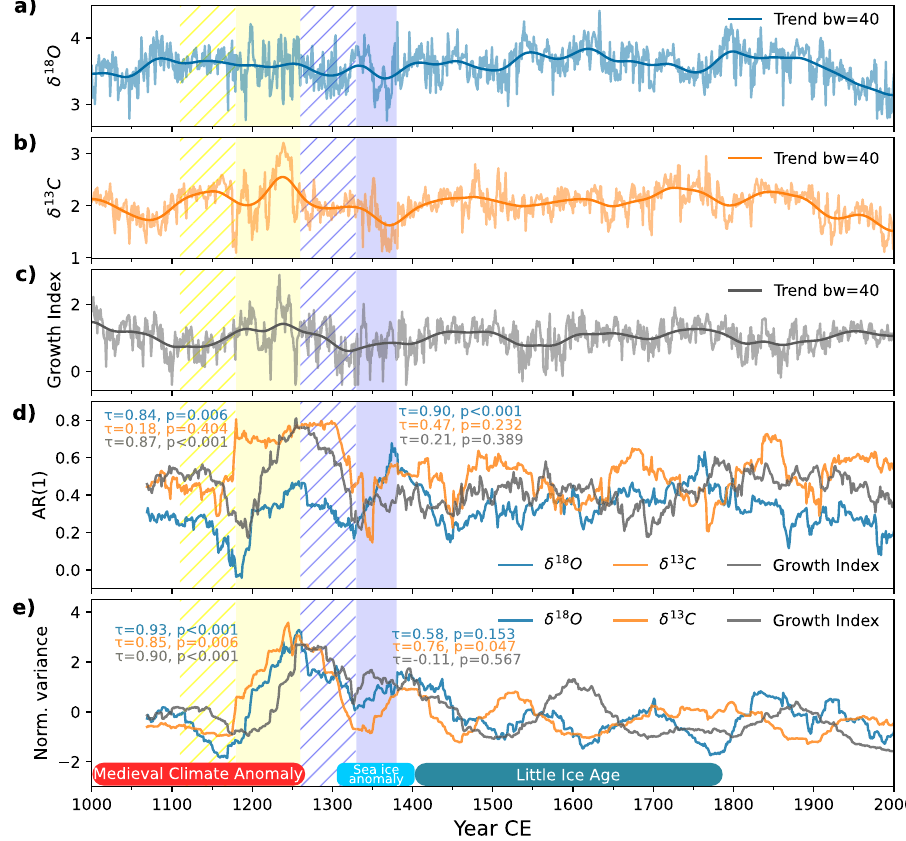
Fig. 2 | Resilience changes measured along the bivalve shell-derived records. a – c Annualvaluesforthe a δ 18 O 24 , b δ 13 C 25 ,and c GrowthIndex 23 records.The thick lines represent the long-term trend estimated using a Gaussian smoothing kernel withabandwidthof40years(seeMethods). d AR(1)and e variancetrendsobtained